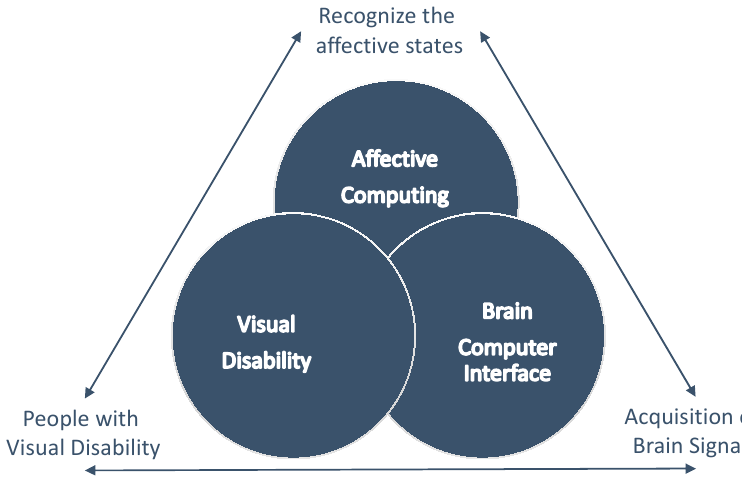
Figure 1. Topics evaluated in this work .